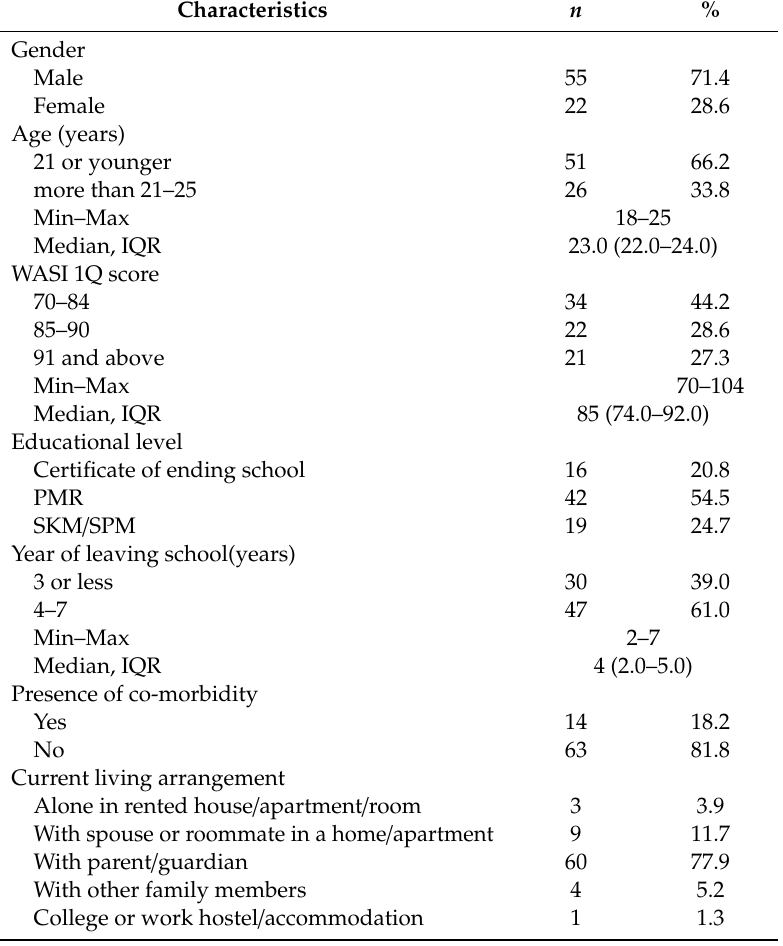
Table 1. Socio-demography characteristics of respondents ( n =